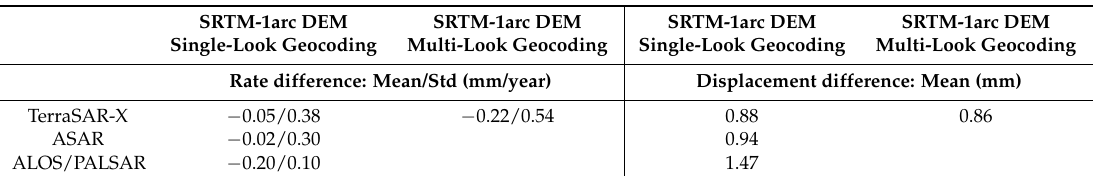
Table 2. The mean deformation rate difference and time-series deformation difference between SRTM-1arc DEM and TanDEM-X DEM with the three platforms.